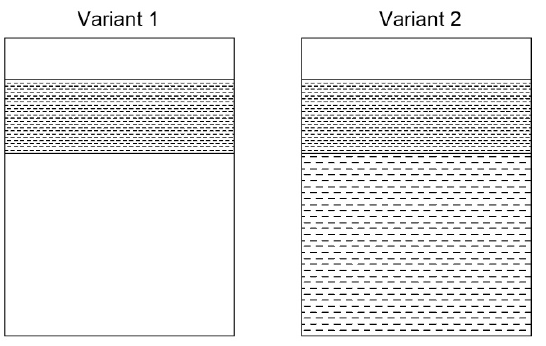
Figure 15. Schemes of cylinder liner surfaces after laser texturing, after [106].